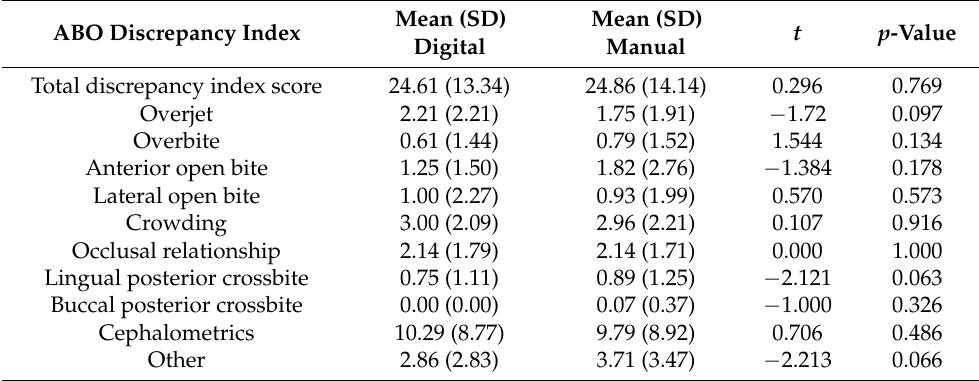
Table 6. Student’s t test comparing the results obtained using digital and manual techniques.